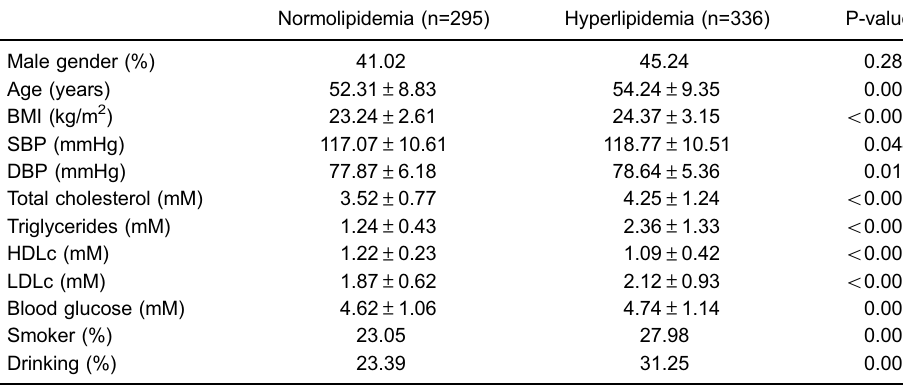
Table 1. Characteristics of the study